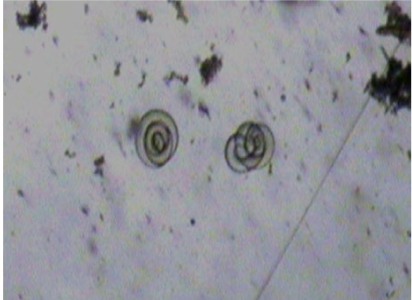
Figure 1. The dead Trichinella spp. larvae detected in raw Polish sausage after artificial digestion